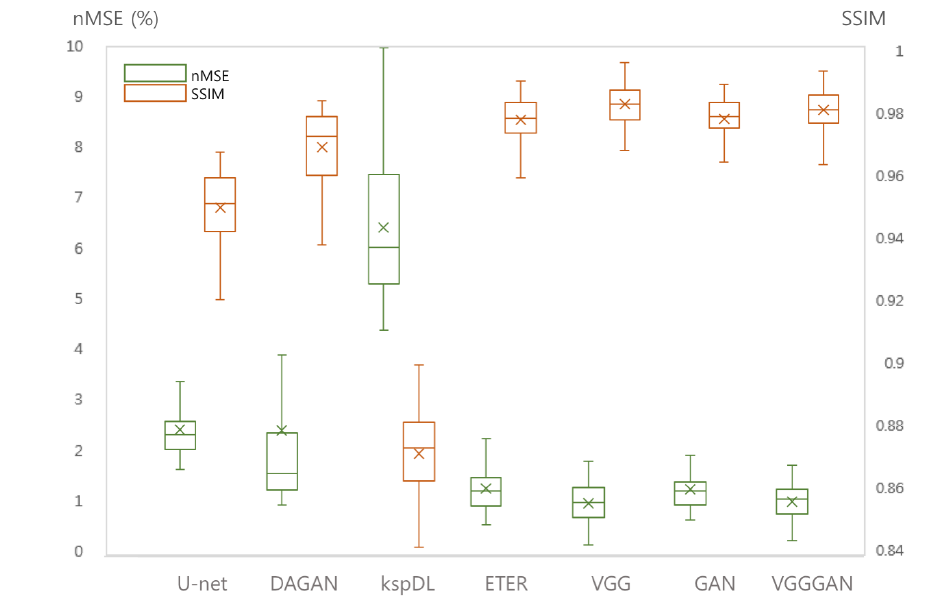
Figure 8. Quantitative analysis of DFU, DAGAN, and the proposed methods with/without additional losses. nMSE and SSIM were measured from 64 slices of four subjects. U-net, DAGAN, kspDL: comparison methods, ETER: with baseline loss function of pixel-wise Euclidean distance, GAN: with additional adversarial loss function, VGG: with additional perceptual loss via pre-trained VGG network, GAN + VGG: with additional adversarial and perceptual loss functions.